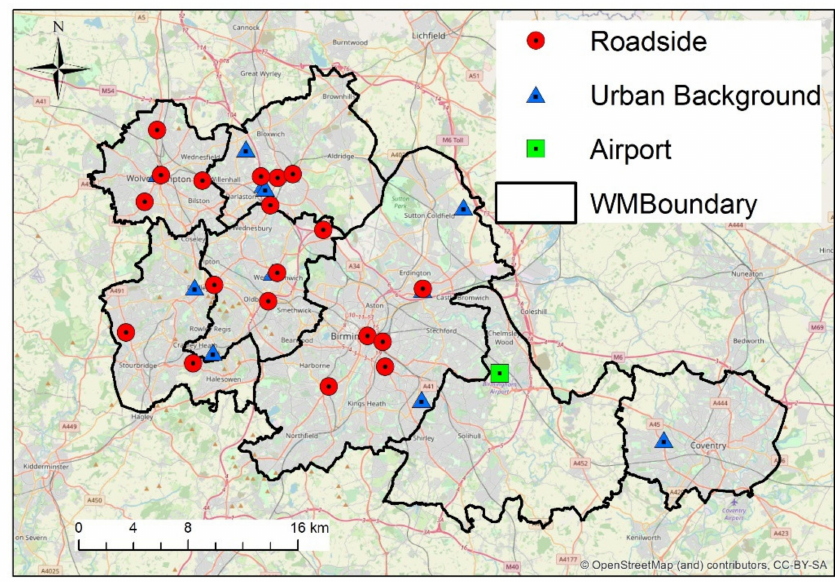
Figure 3. Monitoring sites within West Midland used for the model